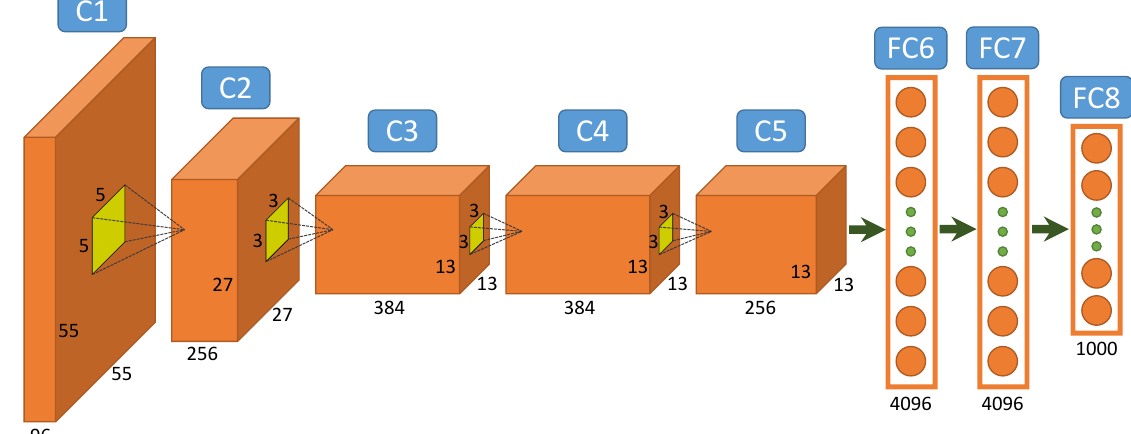
Figure 2. The overall architecture of AlexNet. It is composed of five convolutional layers (C1 − C5) and three FC layers (FC6 − FC8), which becomes the baseline model of modern